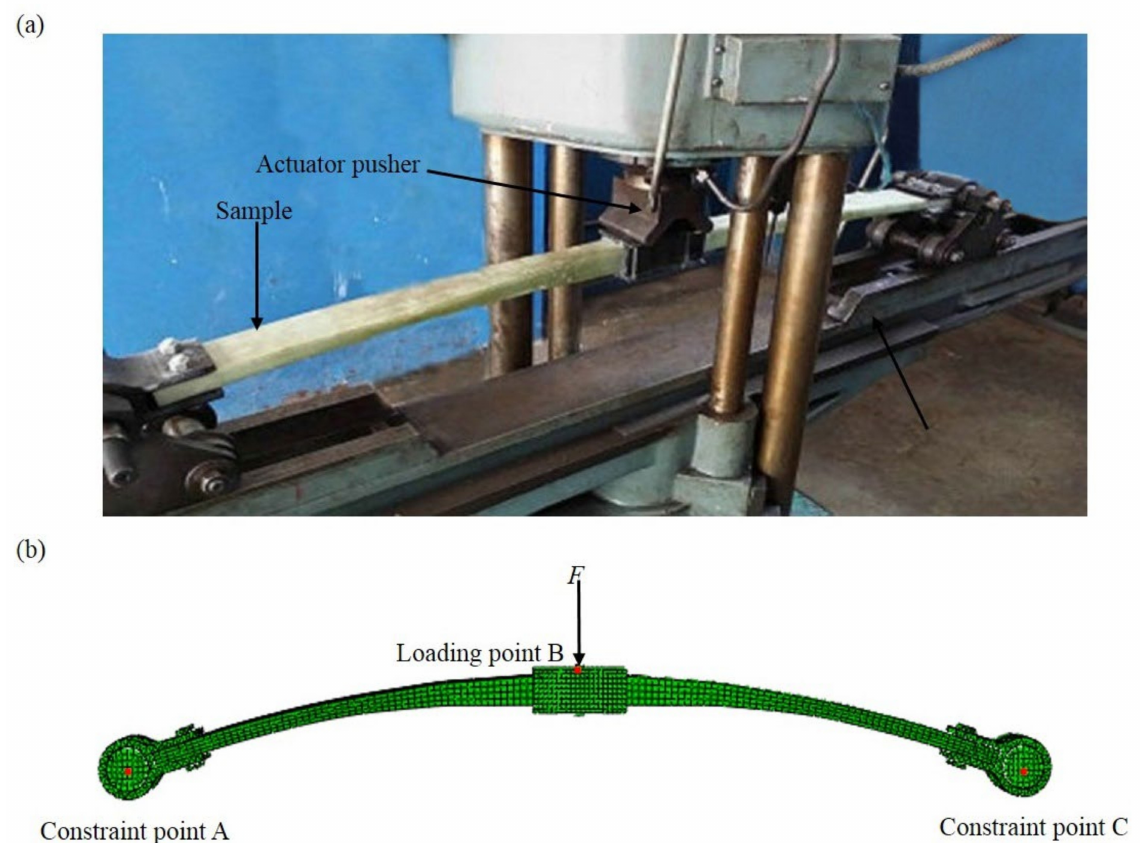
Figure 5. ( a ) A photograph of the test rig and ( b ) finite element (FE) model of the three-point bending test of composite leaf spring: the motion constraint of the joints is realized by constraining the freedom degree of the point A and C at the two